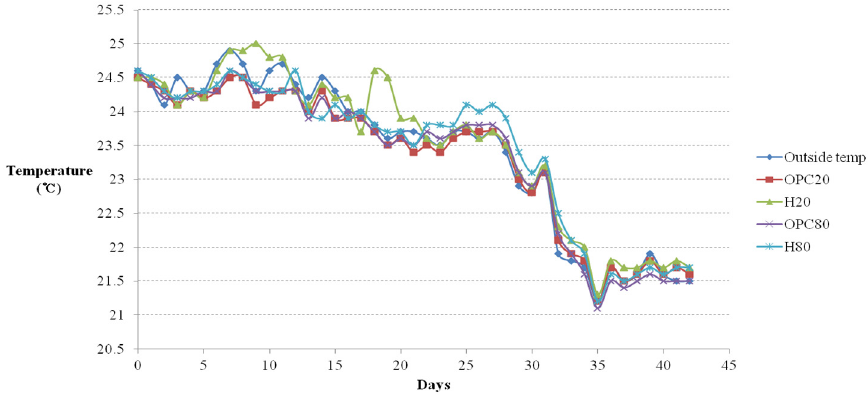
Figure 9. Temperature versus time curves.